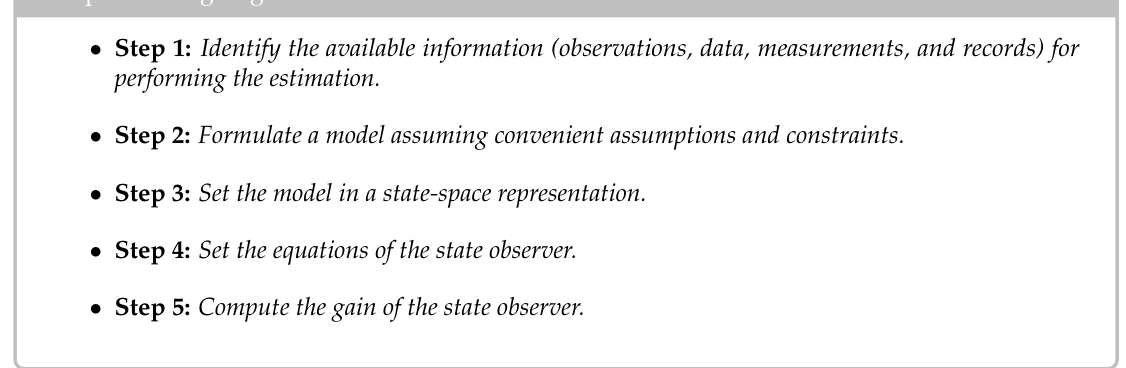
Figure 3. Procedure to design a state